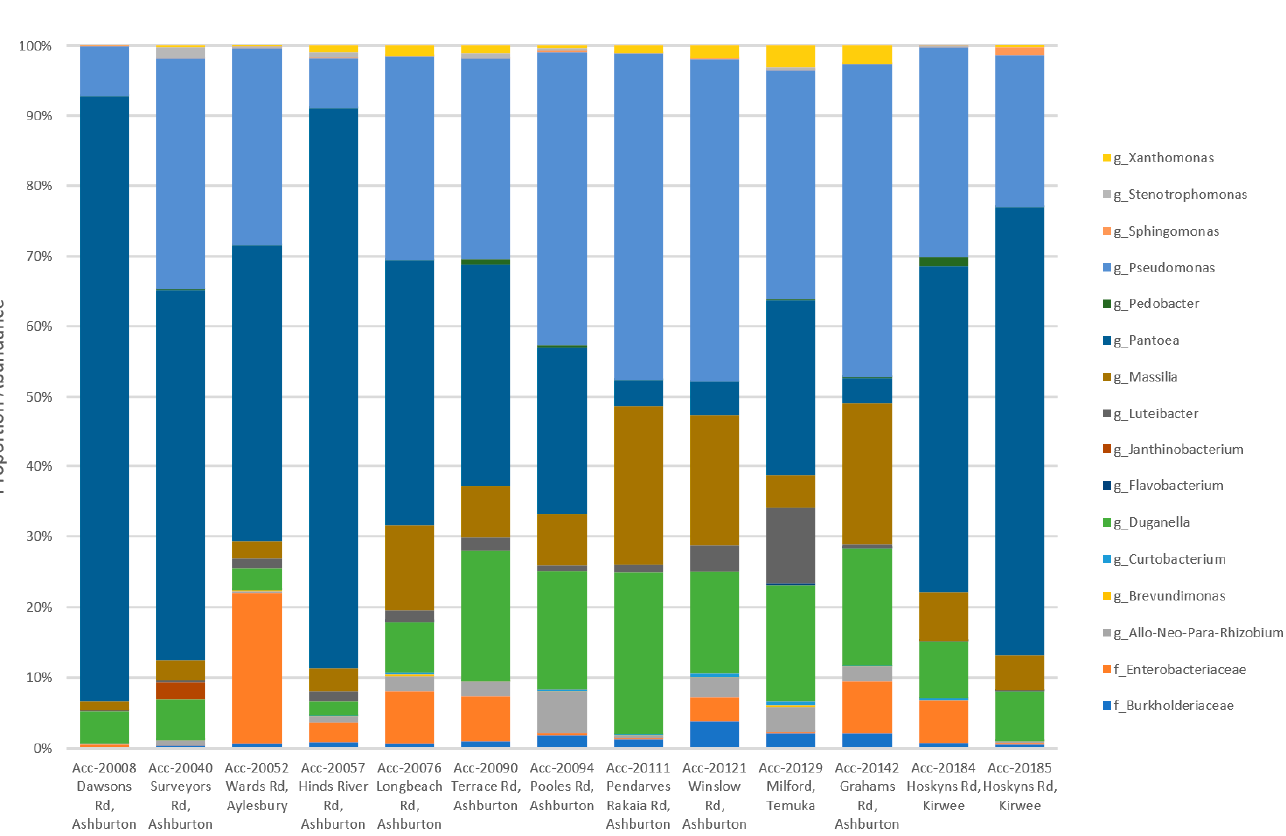
Figure 6. A comparison of genus level profiles of 39 OTUs that each accounted for >1% of the total number of reads from the Biogeography Seed.